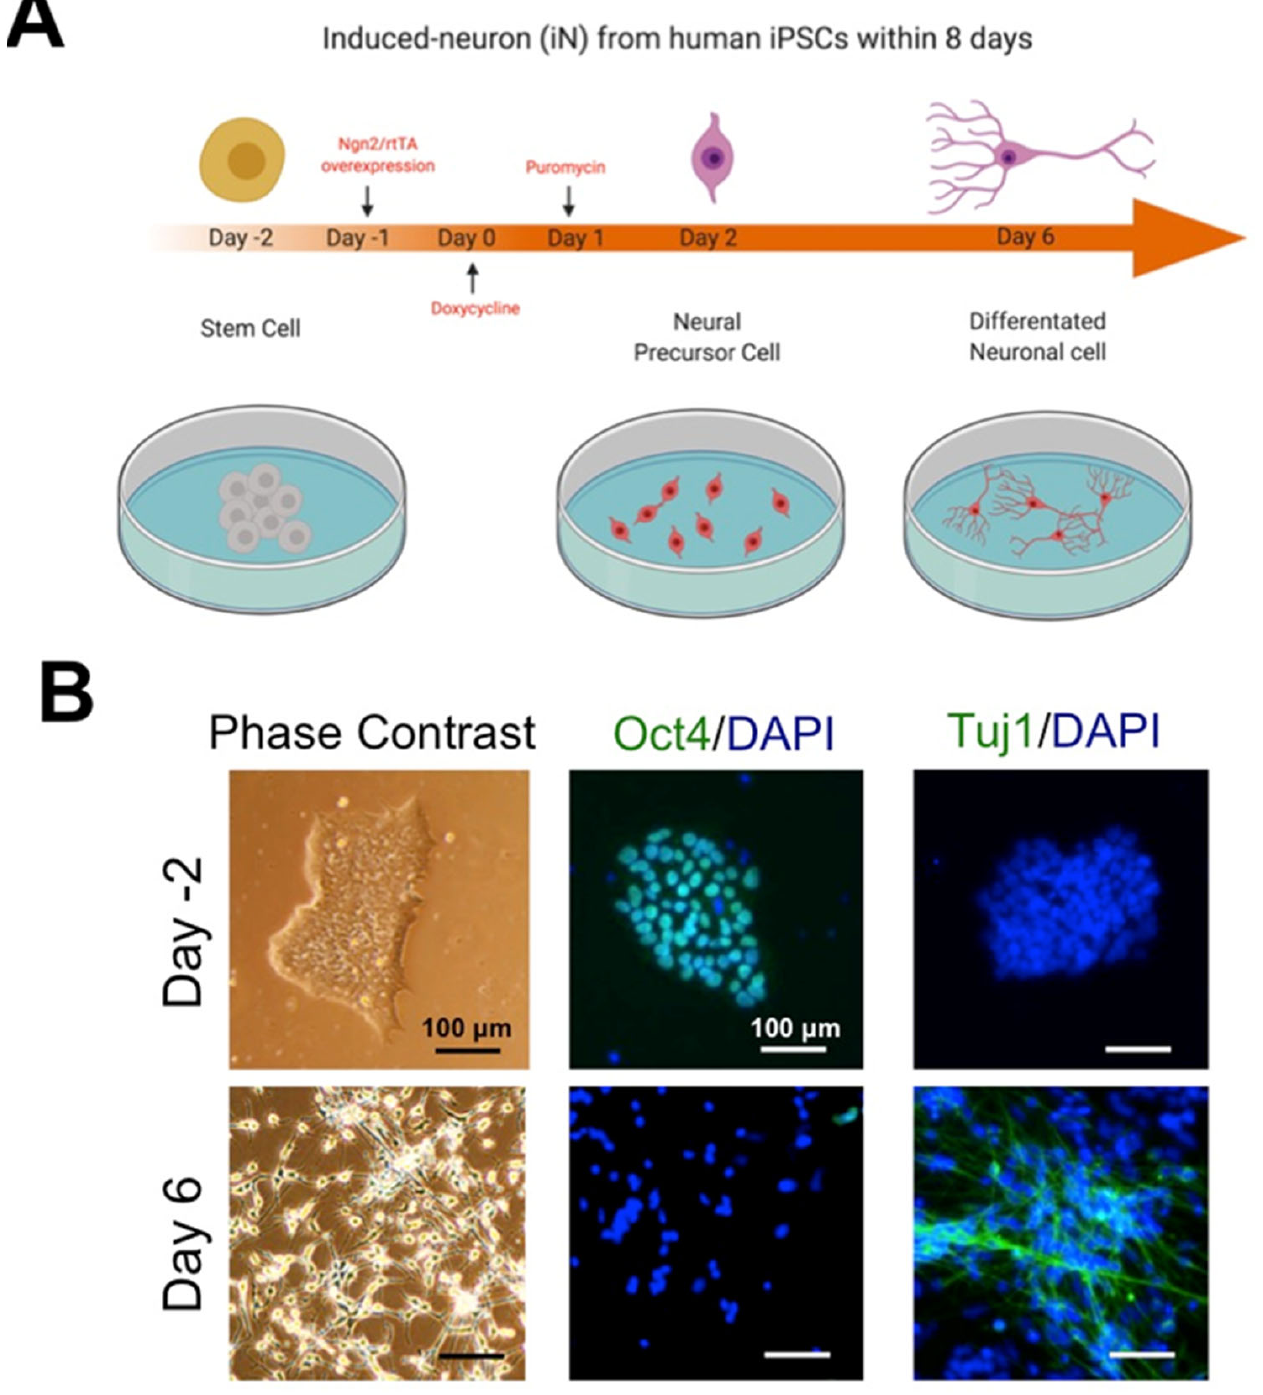
Figure 4. Induced neuron (iN) differentiation from human stem cells. ( A ) Schematic for differentiation of human induced pluripotent stem cells (hiPSCs) into retinal ganglion-like cells. ( B ) Staining for Oct4 and neural marker Tuj1, representing stem cell pluripotency and neurite formation, respectively, in iNs. Scale bar = 100 µm.